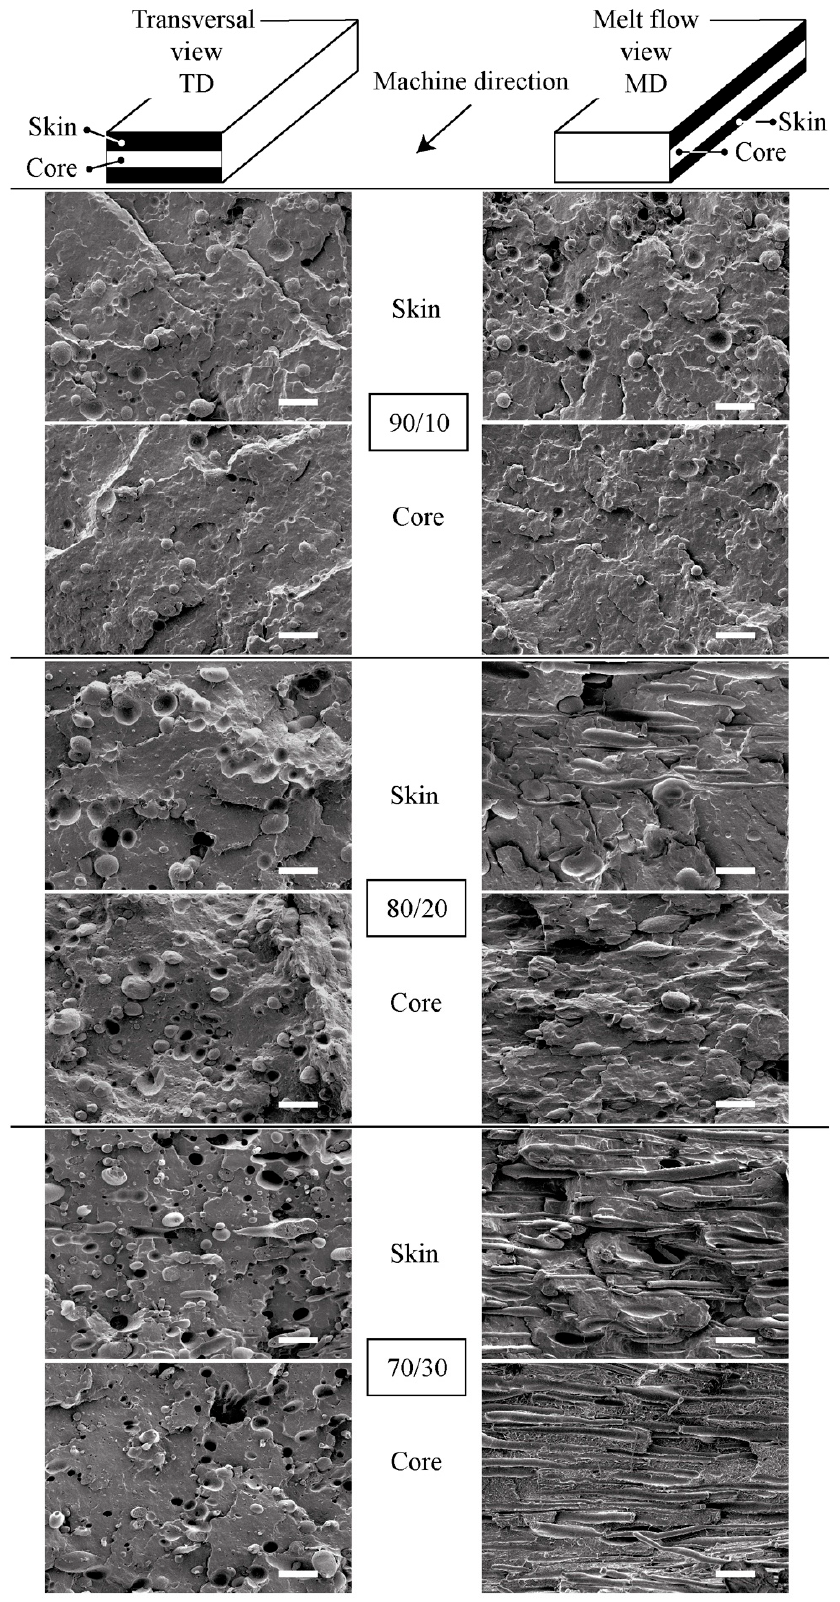
Figure 3. SEM micrographs (×1500) of the cryofractured surfaces of rPP/rPET-O blends in the directions and positions indicated. Scale bars = 10 μ m.